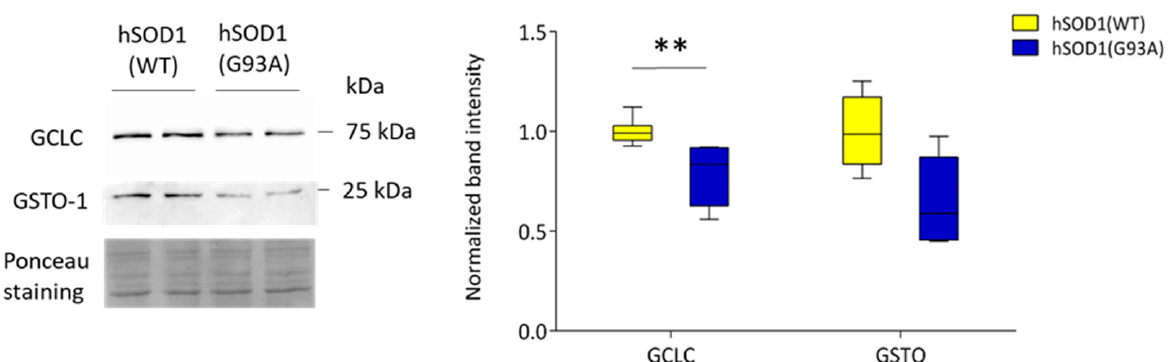
Figure 3. GCLC and GSTO1 are under-expressed in hSOD1(G93A) primary astrocytes-WB validation of GCLC and GSTO1 abundance in hSOD1(G93A) and hSOD1(WT) primary cultures of spinal cord astrocytes. The left panel shows a representative WB. Ponceau staining was used to validate the loading control. The right panel reports the densitometric analysis of GCLC and GSTO-1 immunoreactive bands in the different astrocyte samples normalized to the optical density of the corresponding Ponceau-stained lane. Here and after, black lines in the box plot indicate the median value, while whiskers above and below the box indicate the 5 and 95 percentiles, respectively; n = 5 (biological replicates), ** p < 0.01 (Mann–Whitney U test ).